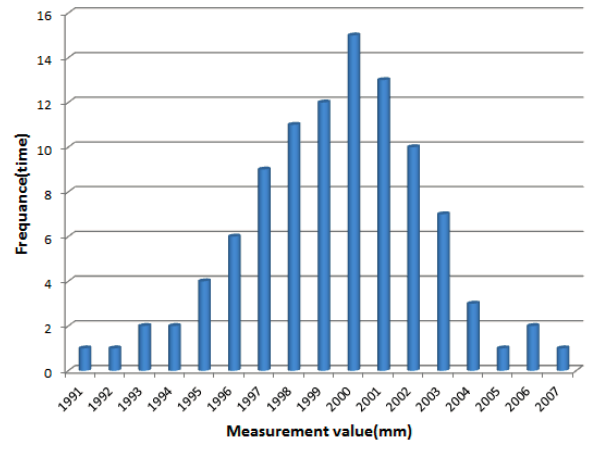
Figure 7. Relation histogram of the measured values vs. to the corresponding